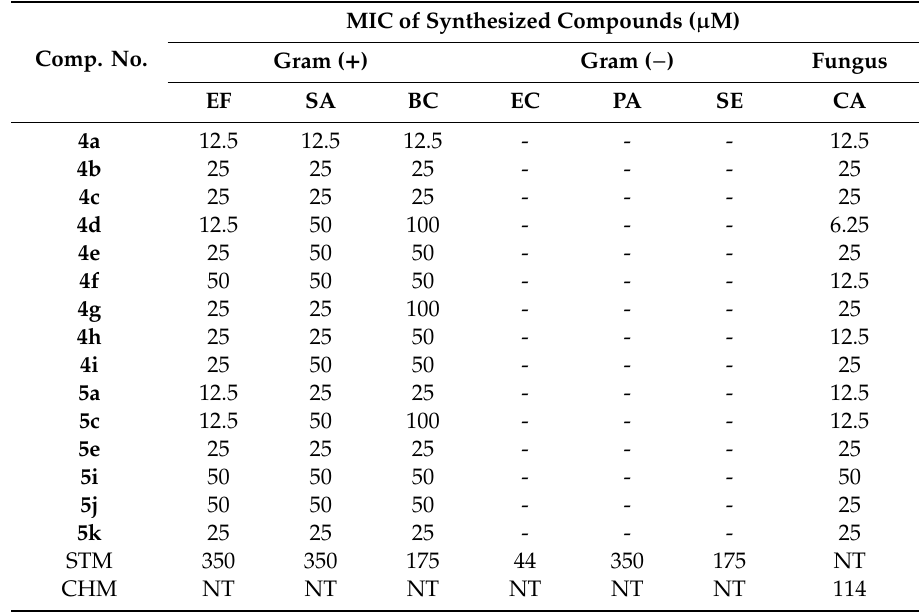
Table 2. Minimum inhibitory concentration (MIC) of synthesized hydrazide-hydrazones 4a – i and 5a – k .